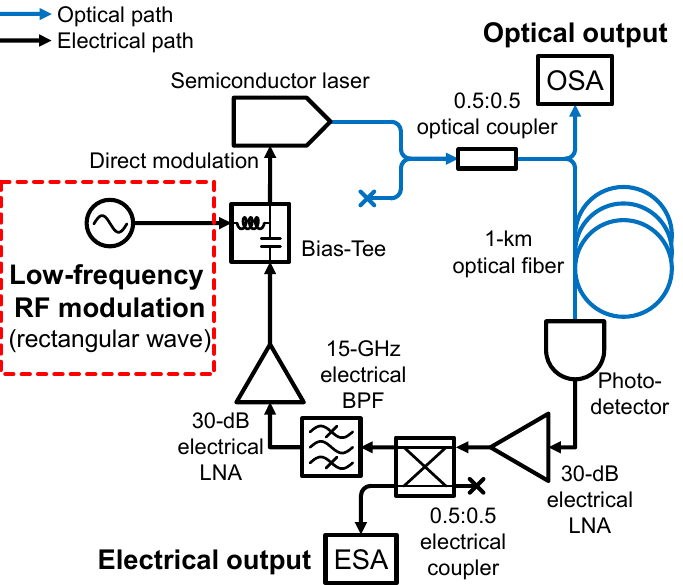
Figure 2. Experimental setup. OSA: optical spectrum analyzer; LNA: low-noise amplifier; ESA: electrical spectrum analyzer; BPF: bandpass filter; RF: radio frequency.